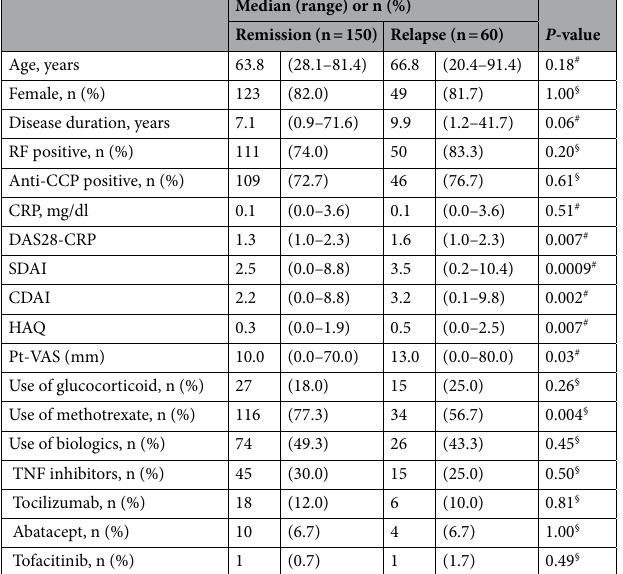
Table 1. Patient characteristics (n = 210). The groups are defined as follows: Remission: Patients with remission in both 2015 and 2017. Relapse: Patients with remission in 2015 and relapse in 2017. RF rheumatoid factor, CCP cyclic citrullinated peptide antibody, CRP C-reactive protein, DAS28 disease activity score on 28 joints, SDAI simplified disease activity index, CDAI clinical disease activity index, HAQ Health Assessment Questionnaire, Pt-VAS patient global assessment with visual analog scale. # Mann–Whitney U test; § Fisher’s exact test.